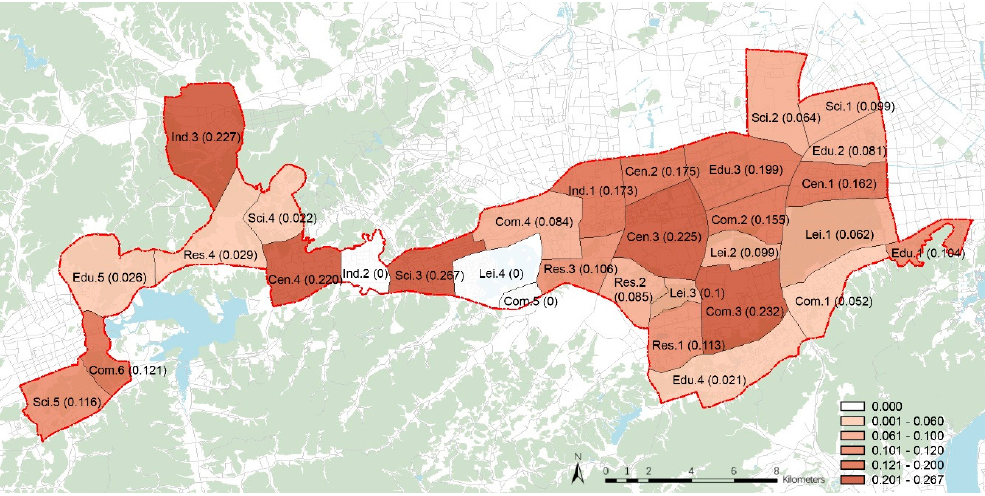
Figure 6. Resident Balance Index of each area in the Corridor.